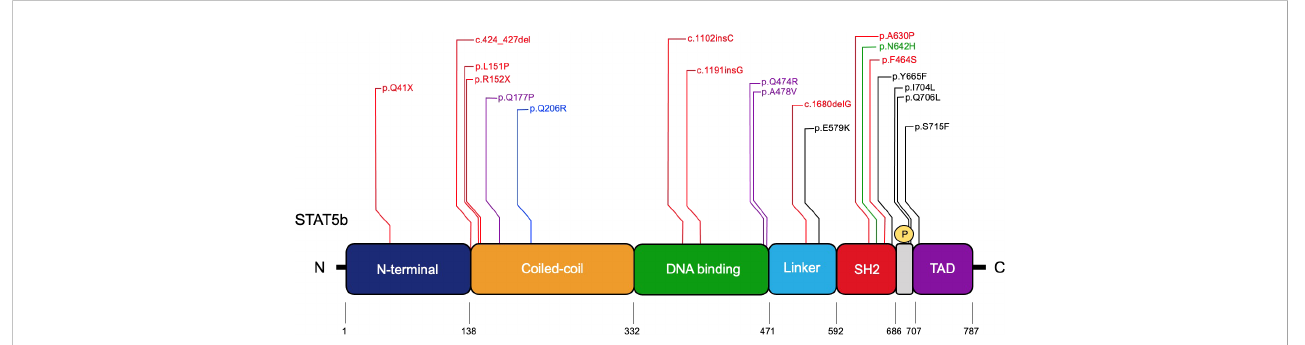
FIGURE 4 Pathologic STAT5B mutations identi fi ed in patients. The STAT5b domains and amino acids residue positions are indicated. Red, homozygous LOF mutations; Purple, dominant-negative LOF mutations with growth hormone insensitivity and eczema; Blue, dominant-negative LOF mutation associated with immune dysregulation lacking growth hormone insensitivity; Green, severe allergic somatic GOF mutation; Black, somatic GOF